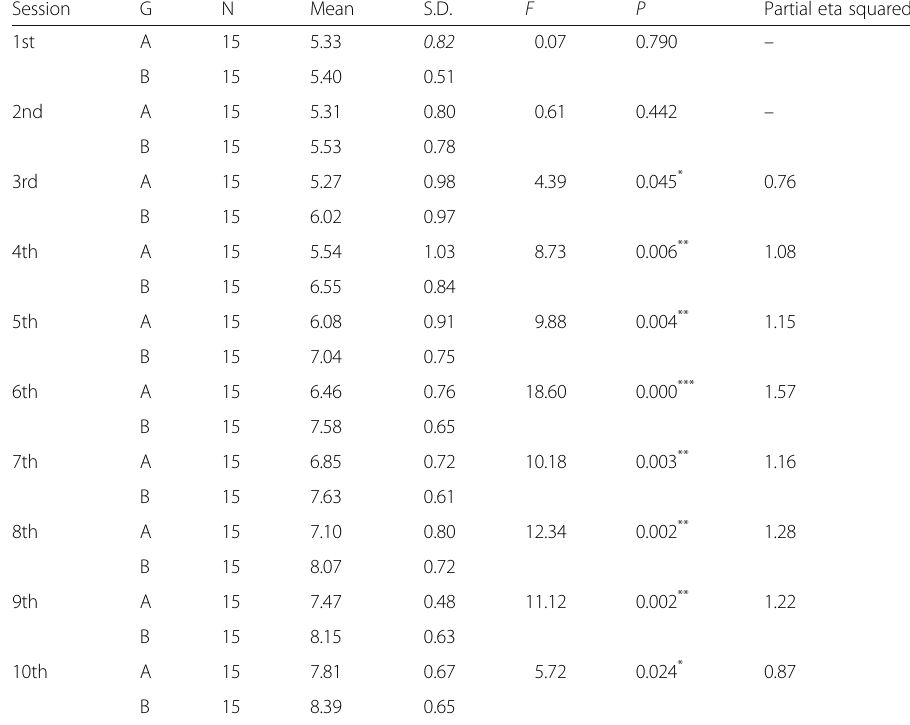
Table 8 The result of ANOVA in the intensity level of each session Session G N Mean S.D. F P Partial eta squared 1st A 15 5.33